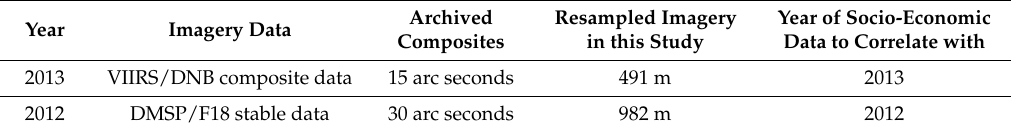
Table 2. Year and spatial resolution of the satellite imagery data used in this study and the year of the corresponding socio-economic data used to correlate with these imagery data. All of the satellite data are obtained from National Geophysical Data Center (NGDC)/Earth Observation Group (EOG).